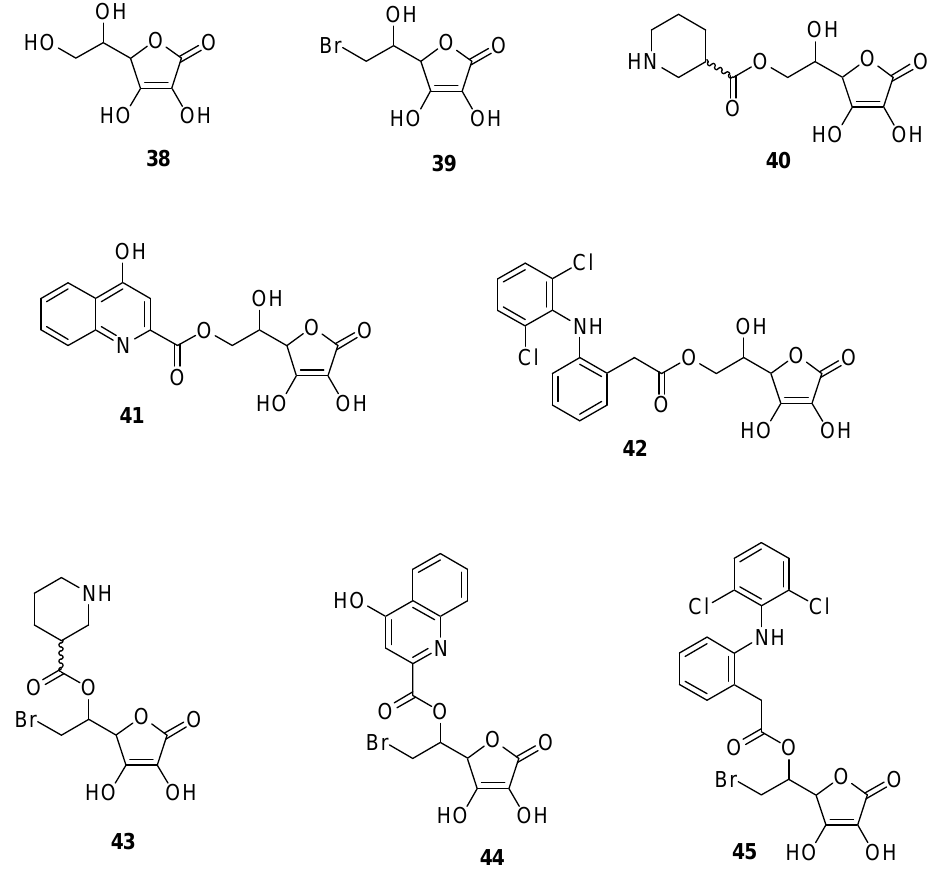
Figure 14: Chemical structures of vitamin C, its Br-ascorbate and their conjugate with nipecotic acid (Nipec), kynurenic acid (Kynur) and diclophenamic acid